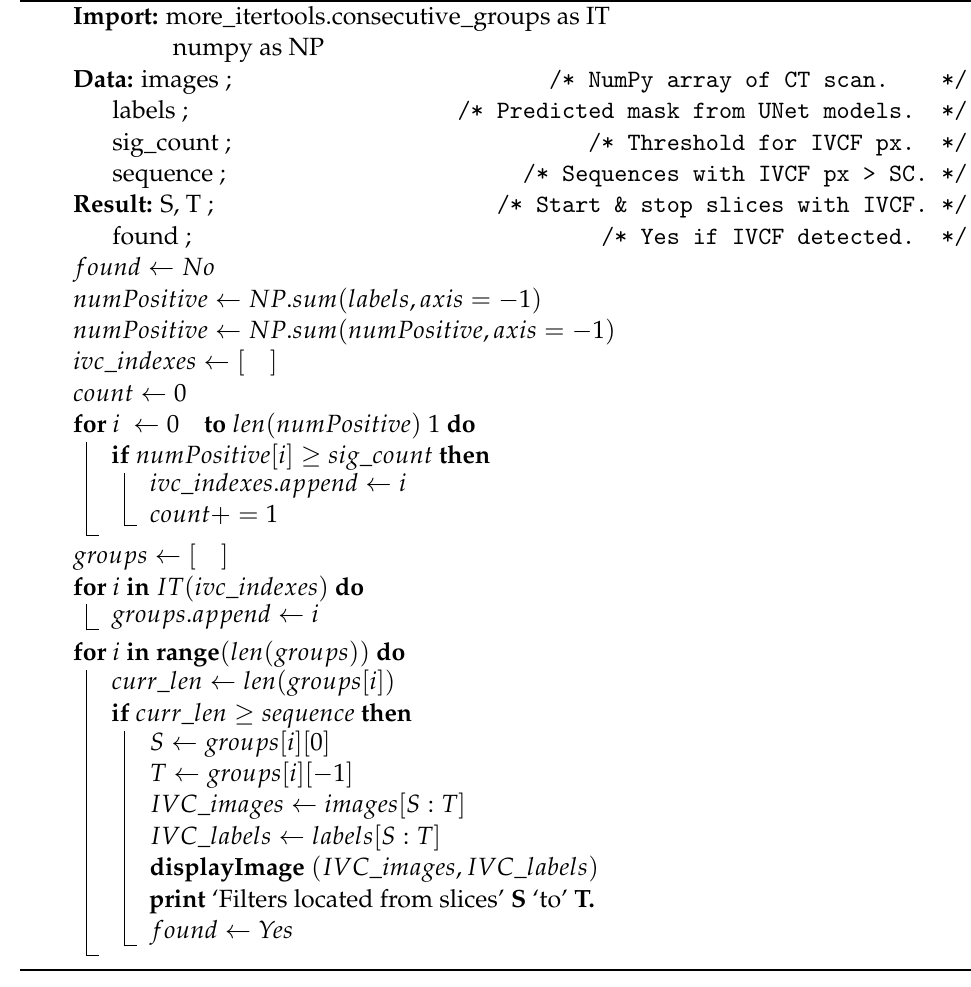
Algorithm 1: IVCF prediction pipeline using the deep learning